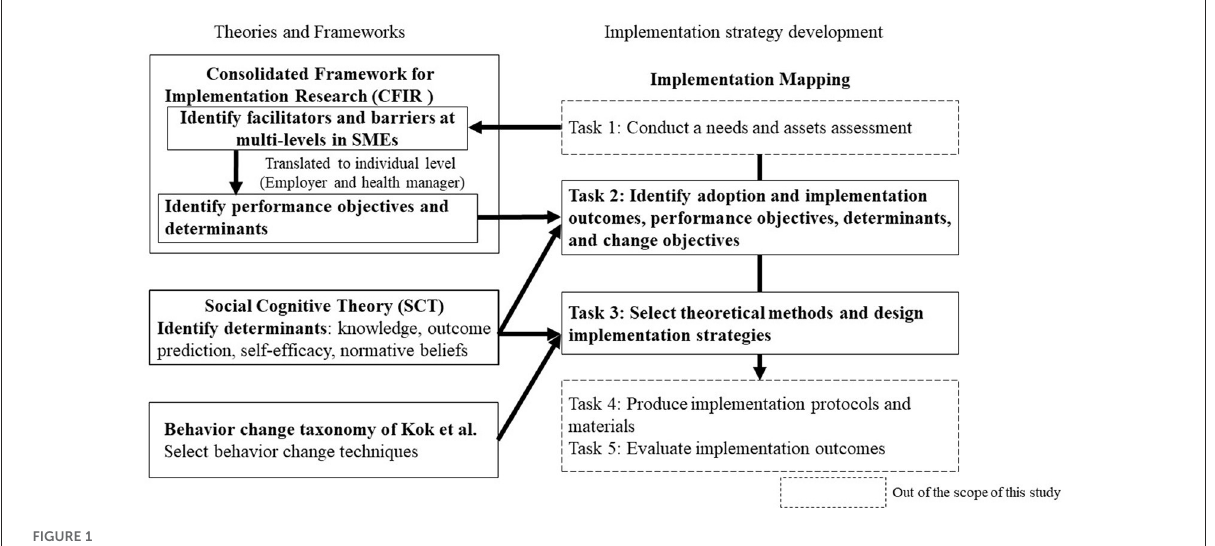
FIGURE1 Conceptual